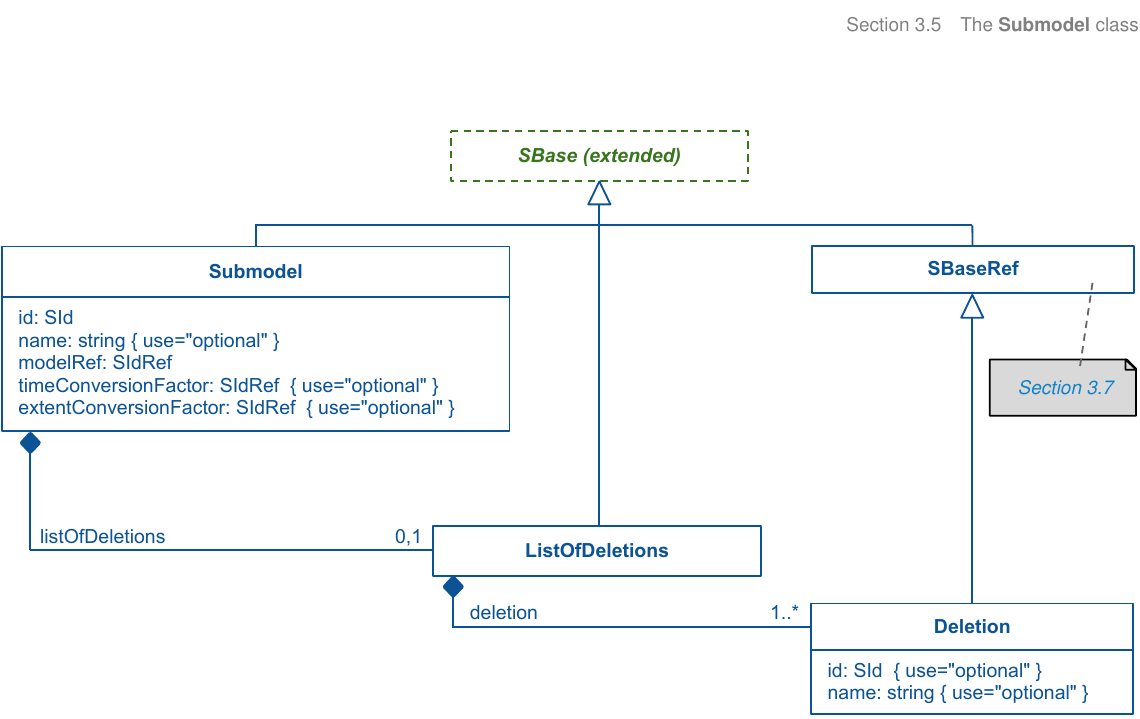
Figure 5: The definition of the Submodel , Deletion and ListOfDeletions